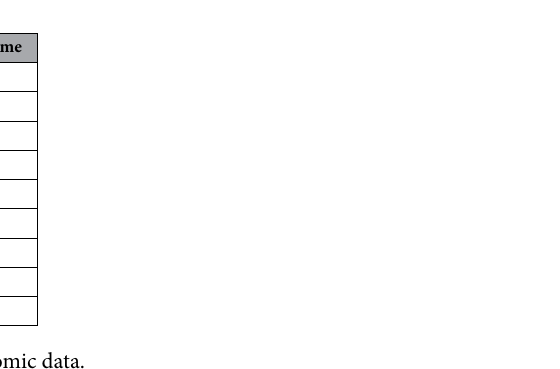
Table 1. General features of the LM genomic